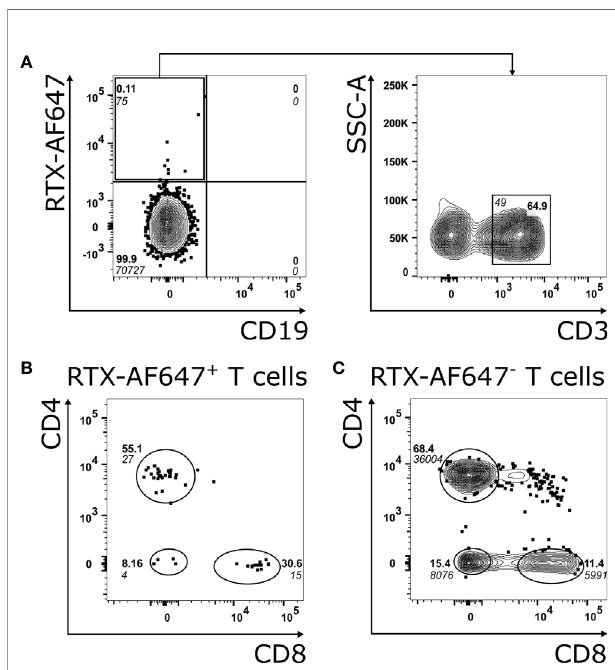
FIGURE 3 | (A) FACS analysis of PBMC from the index MCD patient gated on CD45 + lymphocytes (left panel) shows a population of RTX-AF647 + CD19 − cells and no CD19 + B cells prior to rituximab treatment. CD3 is expressed on 64.9% of RTX-AF647 + CD19 − cells ( A , right panel). (B) CD4 and CD8 expression of RTX-AF647 + CD3 + cells (RTX-AF647 + T cells). (C) CD4 and CD8 expression of RTX-AF647 − CD3 + cells (RTX-AF647 − T cells). In the blood of the index MCD patient, RTX-AF647 + T cells (B) are enriched for CD8 + T cells and show a reduced frequency of CD4 + T cells and double negative T cells in comparison to RTX-AF647 - T cells (C)